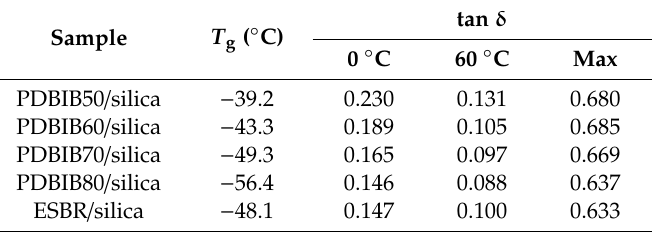
Figure 10. Temperature dependence of loss tangent (tan δ ) for PDBIB/silica and ESBR/silica nanocomposites. Table 8. Dynamic mechanical thermal analysis of PDBIB/silica and ESBR/silica nanocomposites.